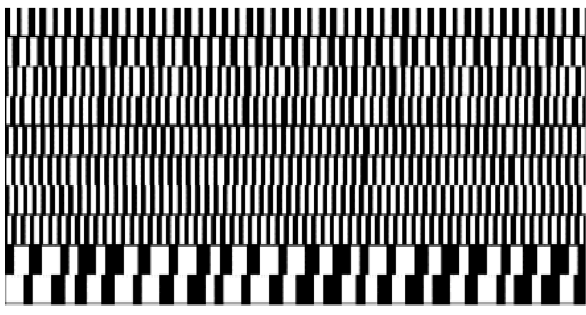
Figure 3: Maximum min-SW gray